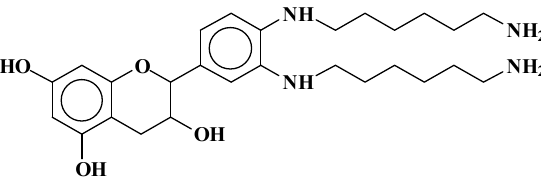
Figure 4. Example of covalent bonds structure at 509–512 Da.